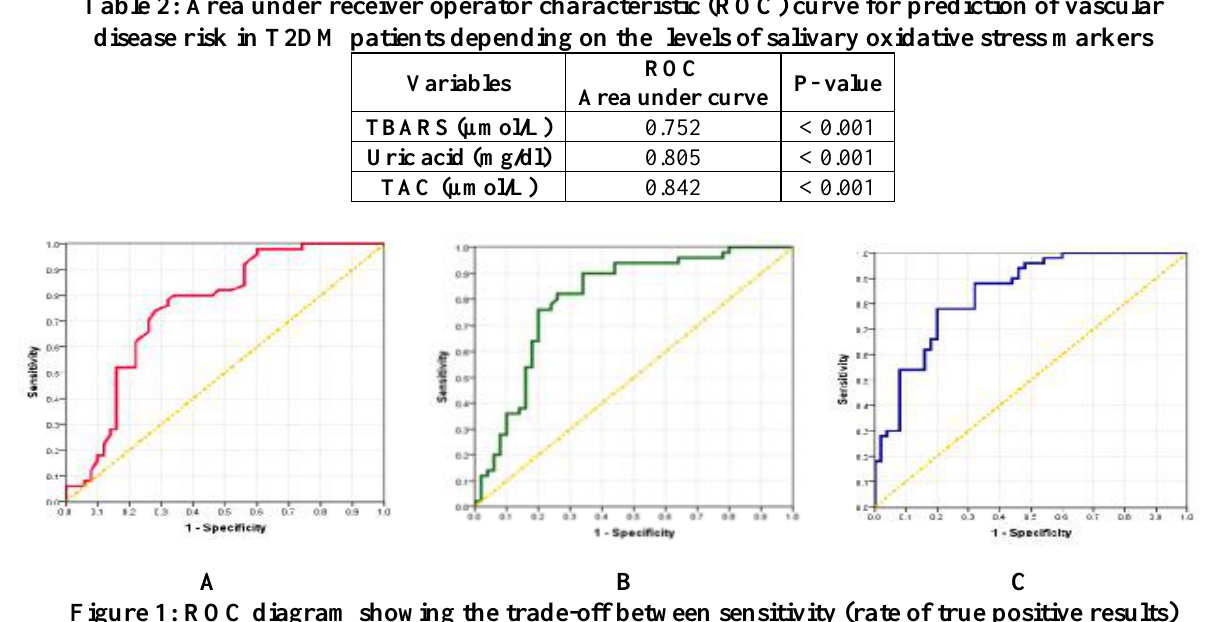
Figure 1: ROC diagram showing the trade-off between sensitivity (rate of true positive results) and 1-specificity (rate of false positive test results) for A.TBARS, B. uric acid and C. total antioxidant measurements when used as a test to predict VD risk in T2DM patients, differentiating them from T2DM patients without VD